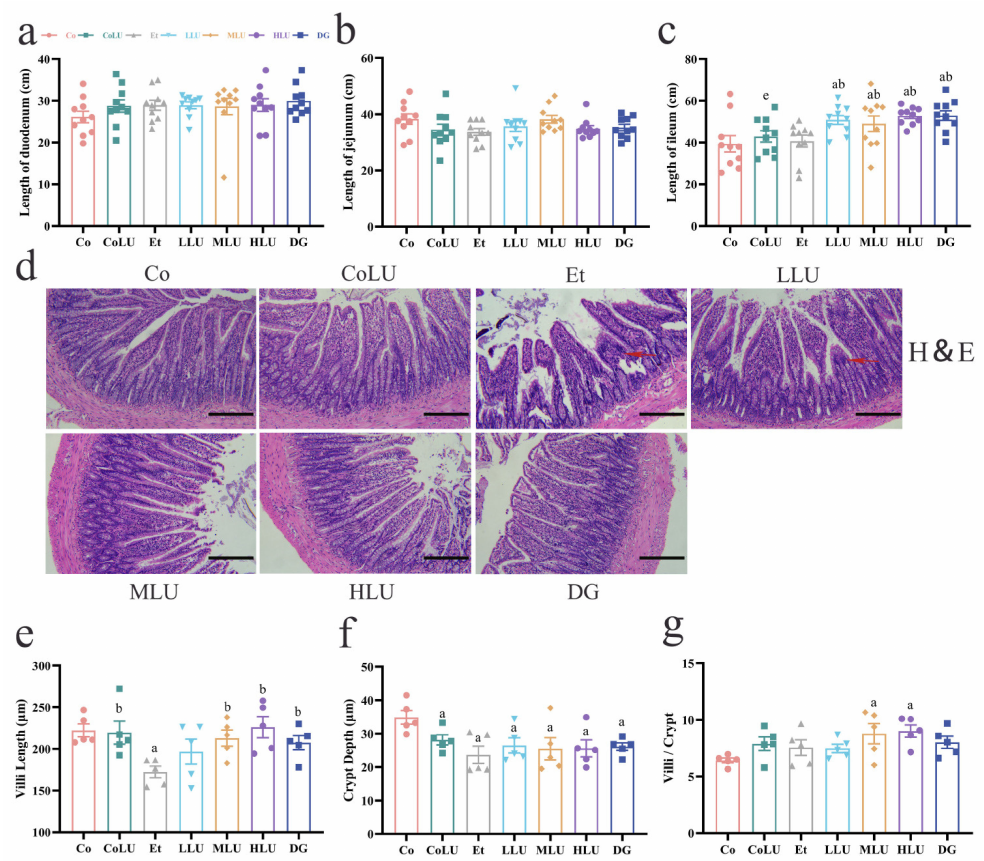
Figure 5. Effect of lutein on the small intestine tissue. Length of the duodenum ( a ), jejunum ( b ), and ileum ( c ) ( n = 10/group). Ileum H&E staining ( d ) (scale bar = 50 µ m, magnification 200 × ; red arrows indicate intestinal villi atrophy). Small intestinal villus length ( e ), crypt depth ( f ), and villus length to crypt depth ratio ( g ) ( n = 5/group). The data were shown with mean ± SEM. Co: normal control group; CoLU: the medium-dose lutein control group; Et: ethanol model group; LLU: the low-dose lutein intervention group; MLU: the medium-dose lutein intervention group; HLU: the high-dose lutein intervention group; DG: positive control group. a p < 0.05 vs. Co group, b p < 0.05 vs. Et group, e p < 0.05 vs. HLU